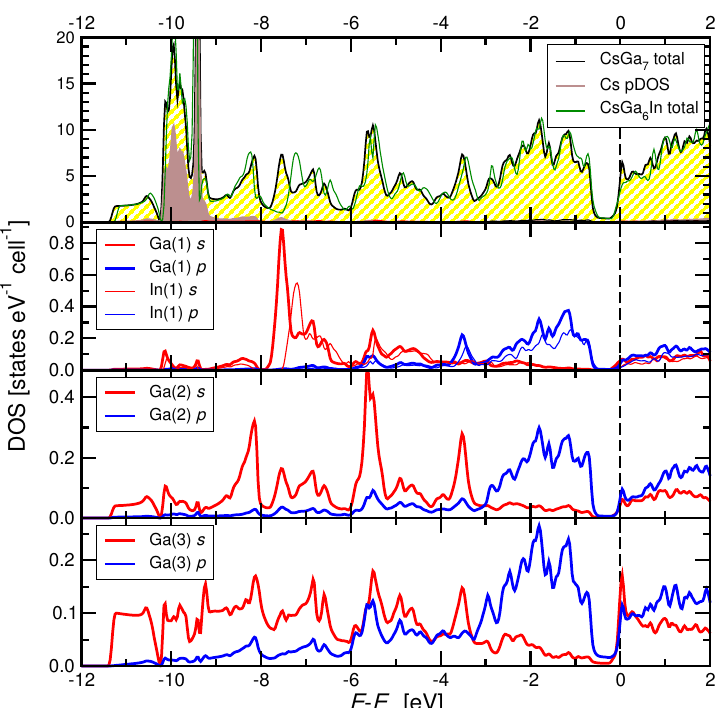
Figure 3. Total (top) and partial Ga- s (red) and Ga- p (blue) density of state (DOS) of CsGa with the total DOS (tDOS) and the In(1) partial DOS (pDOS) of “CsGa